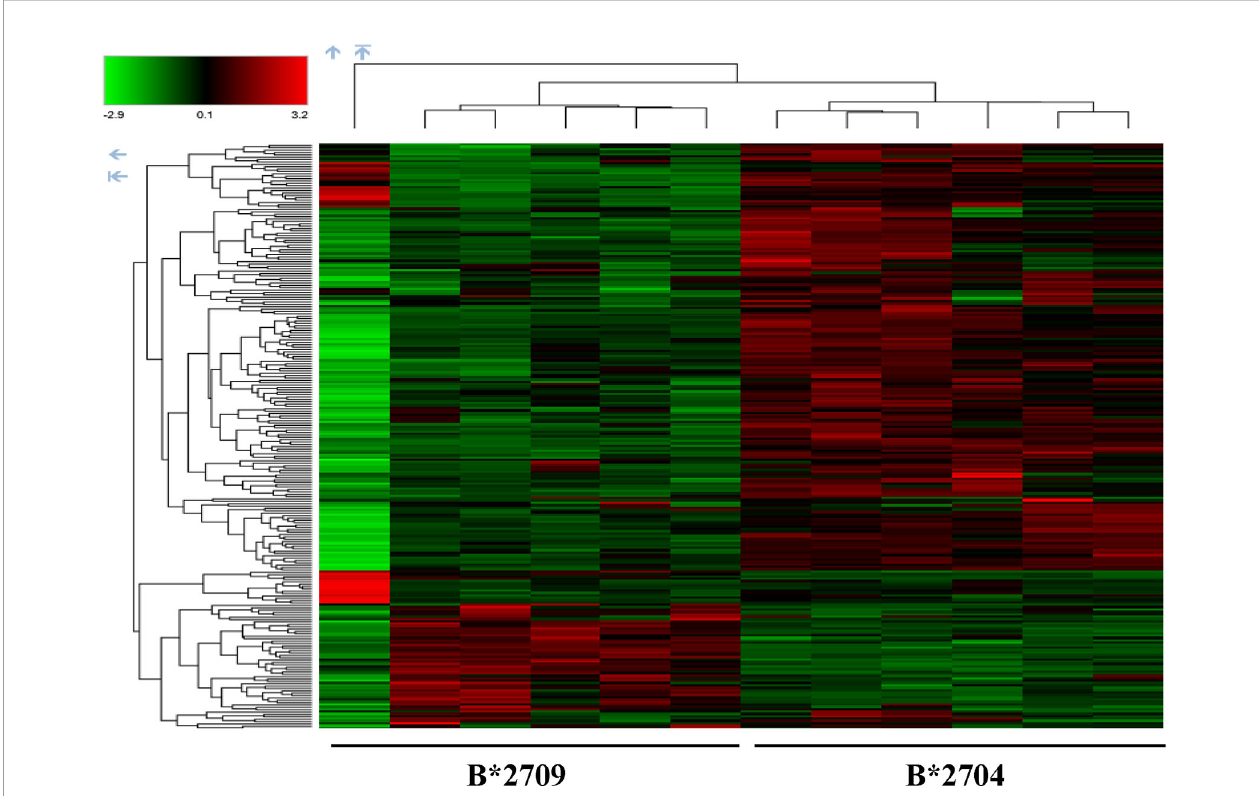
FIGURE 1 | Hierarchical clustering and heat map based on label-free proteome quanti fi cation, representing color-coded expression levels of differentially expressed proteins in cells transfected with the two subtypes of HLA-B27. Red color represents the upregulated proteins, while green shows the downregulated proteins in the two cell types, with 6 biological replicates in each